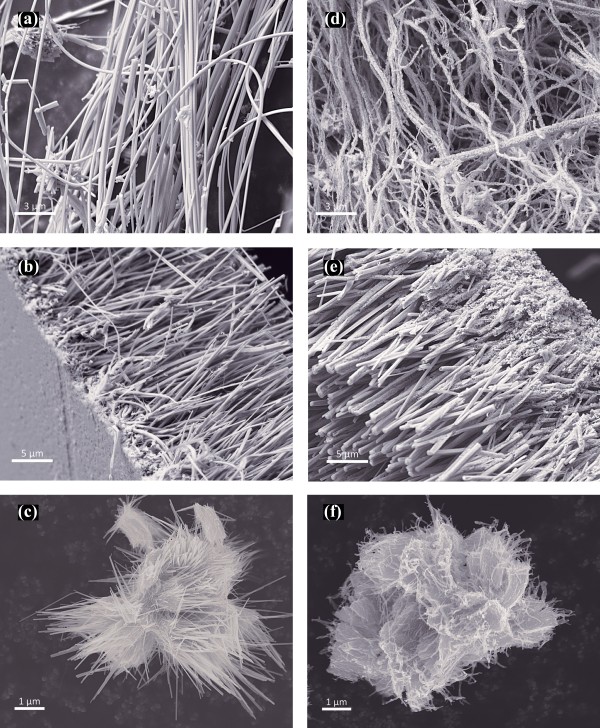
SEM images showing several morphologies of as-synthesized MoSI NWs templates. Left panel (a, b, c) and their corresponding structures after hydrogenation to produced Mo NWs at the right panel (d, e, f).